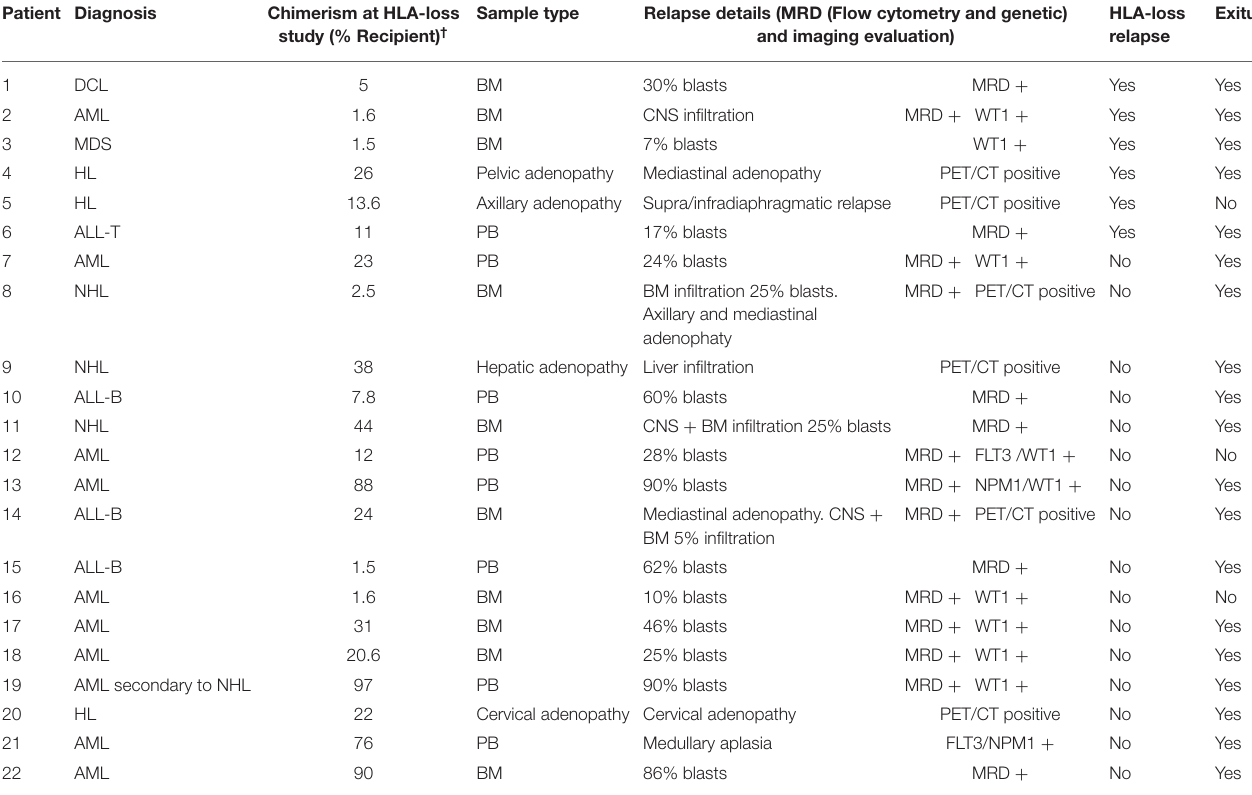
TABLE 1 | Chimerism and relapse data of 22 patients relapsed after Haplo-HSCT with PTCy. Patient Diagnosis Chimerism at HLA-loss Sample type Relapse details (MRD (Flow cytometry and genetic) HLA-loss study (% Recipient) † and imaging evaluation)